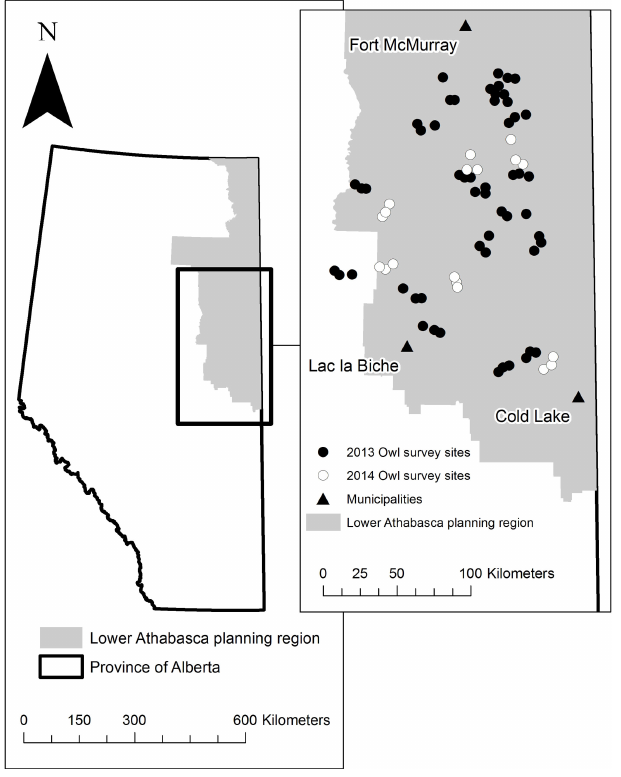
Fig. 1 . Map of owl site locations within the Lower Athabasca Planning Region (LAPR) in northeastern Alberta. Sites were located > 3 km apart.